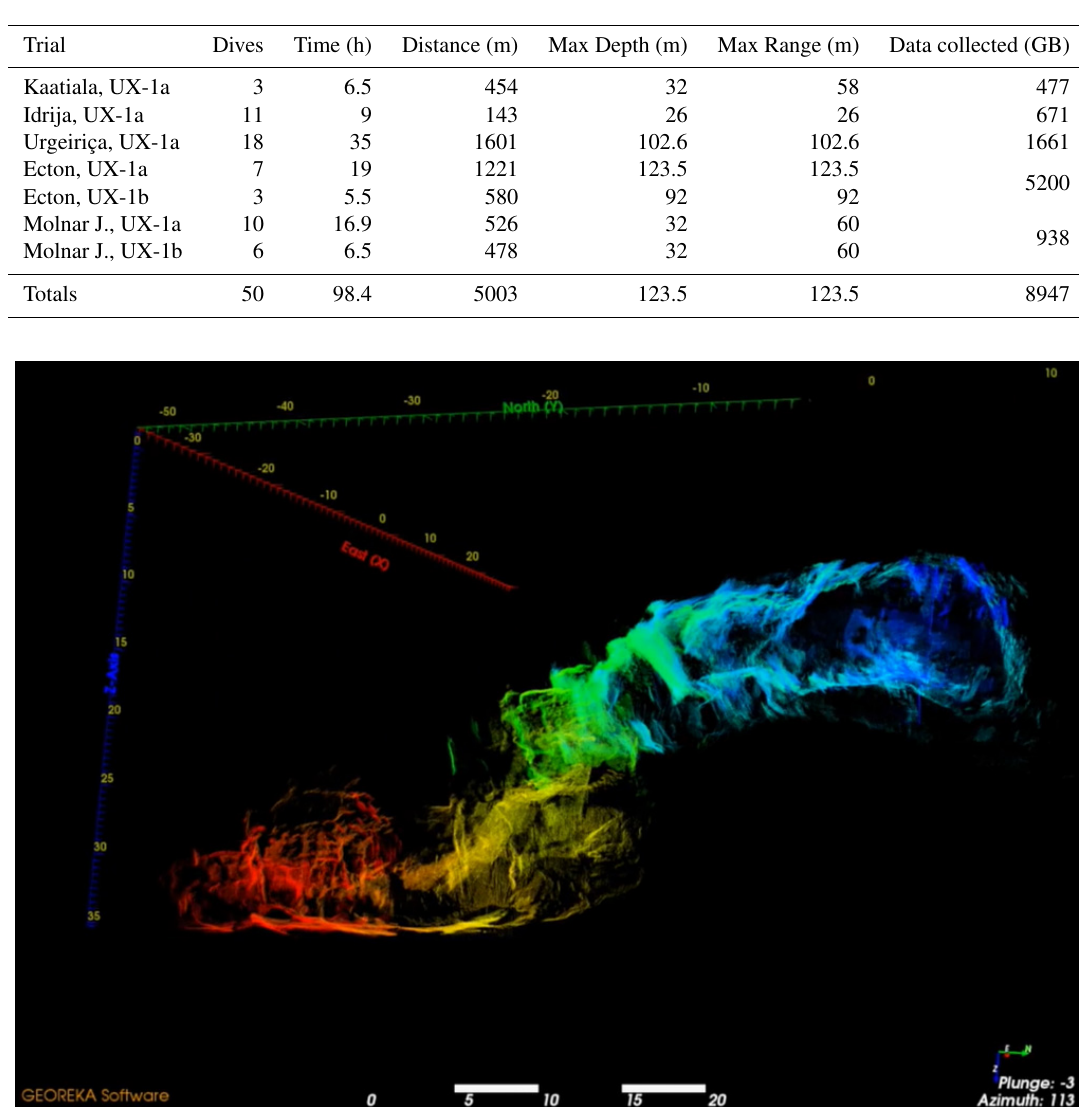
Figure 2. Post-processed data from the Molnár János cave – Budapest, Hungary (figure from UNEXMIN GeoRobotics Ltd.).